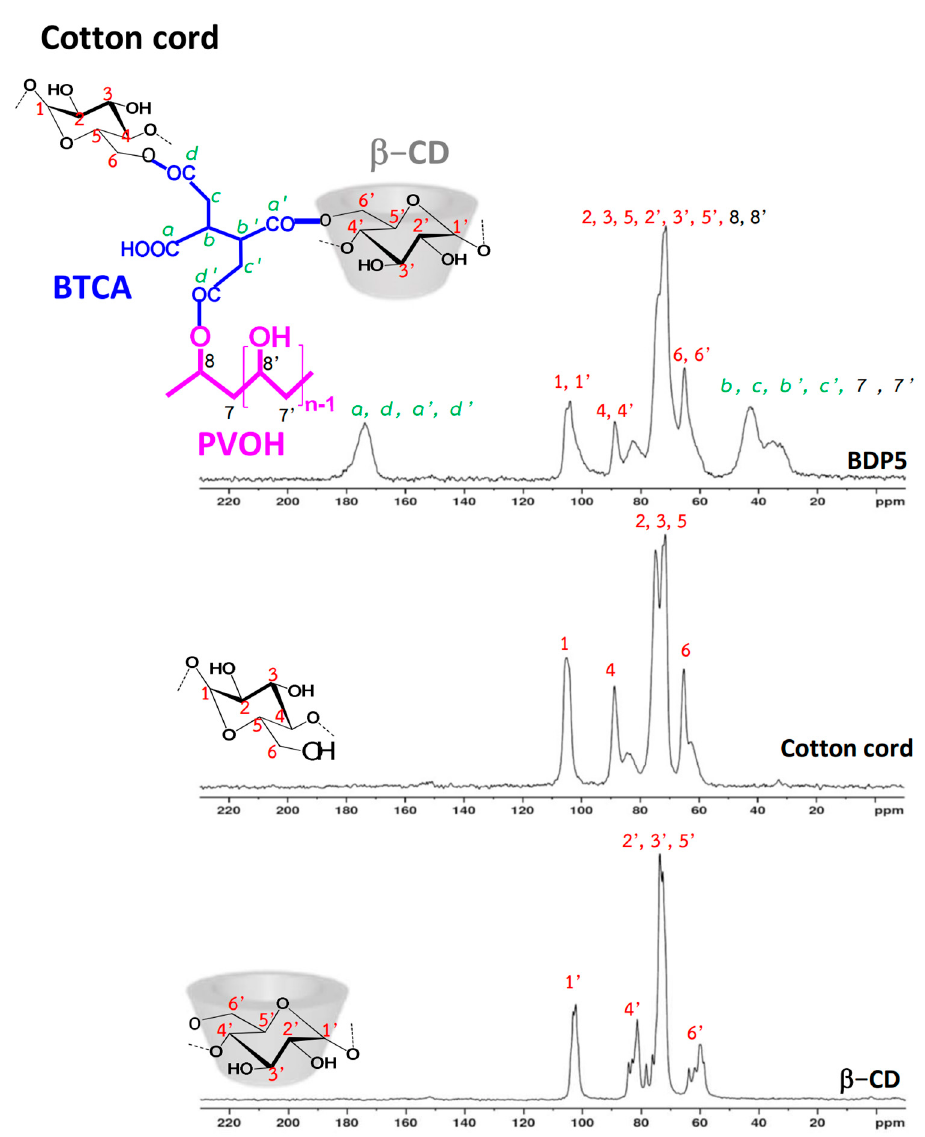
Figure 5. 13 C NMR spectra of β− CD, cotton cord, and BDP5.